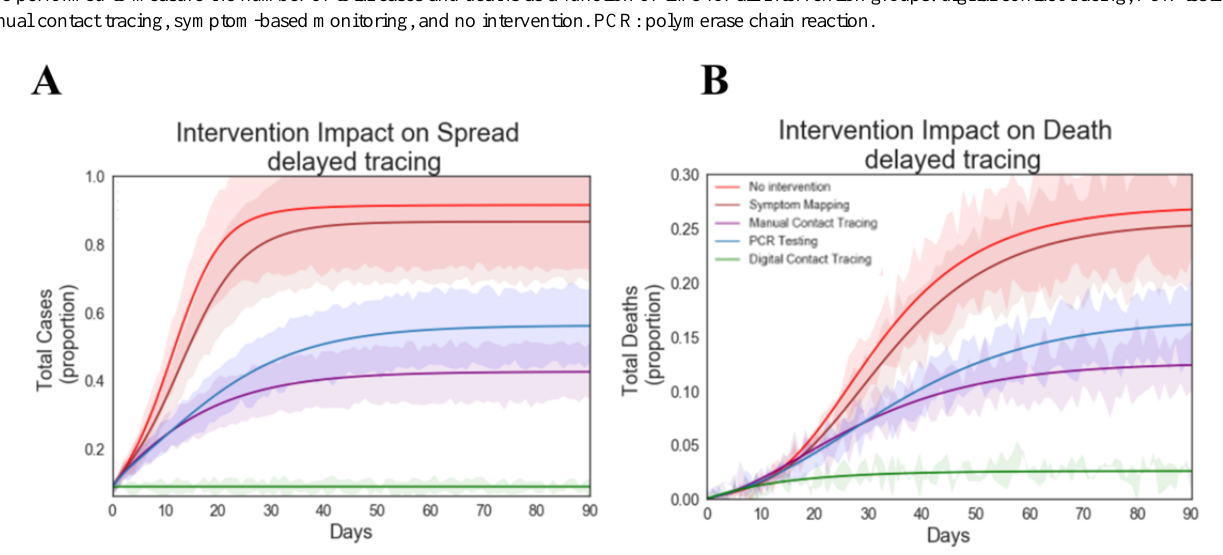
Figure 6. Effect of tracing delays on intervention performance. A: total cases (proportion) over time. B: total deaths (proportion) over time. Simulations were performed for all intervention groups using initial seeding conditions: 10 cases (40% presymptomatic and 60% symptomatic cases). Time delay to trace for digital contact tracing (0.1 days), symptom-based mapping (3 days), manual contact tracing (4 days), and PCR testing (3 days). Simulations were performed to measure the number of total cases and deaths as a function of time for all intervention groups: digital contact tracing, PCR testing,